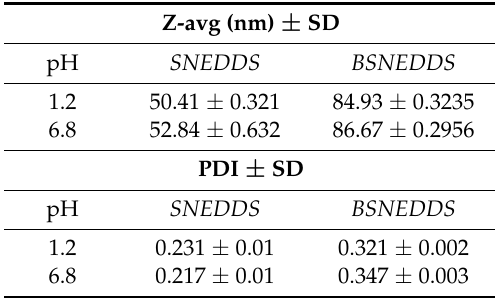
Table 3. Effect of pH and drug loading on Z-avg and PDI after dispergation of unloaded and loaded Self-nanoemulsifying formulations (Mean ± SD; n =